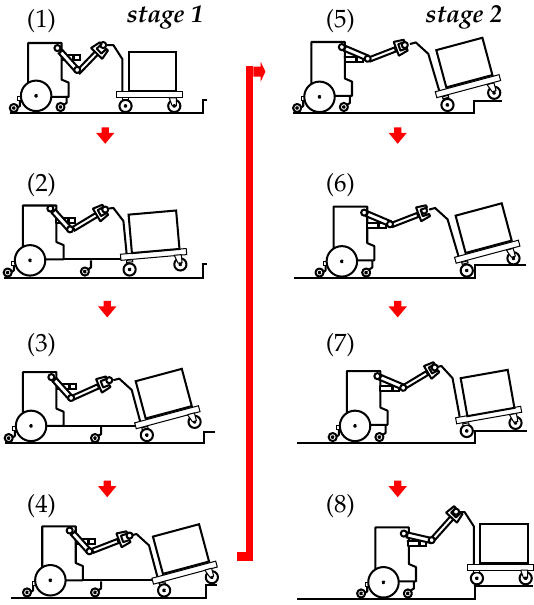
Figure 15. Step-climbing process of the hand cart Figure 16. Step-climbing process of the robot